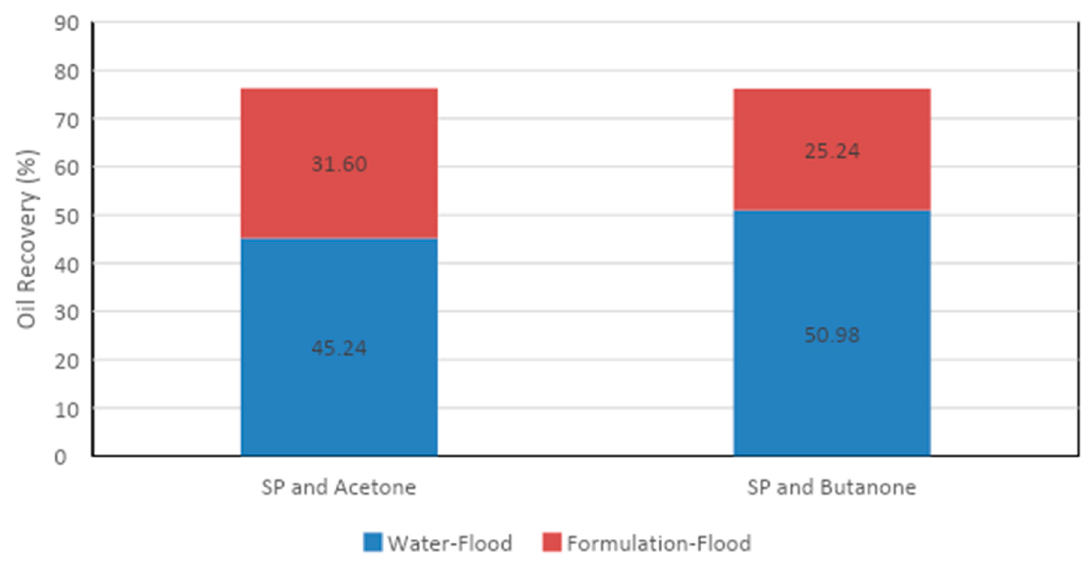
Figure 14. Total oil recovery from the two formulations.